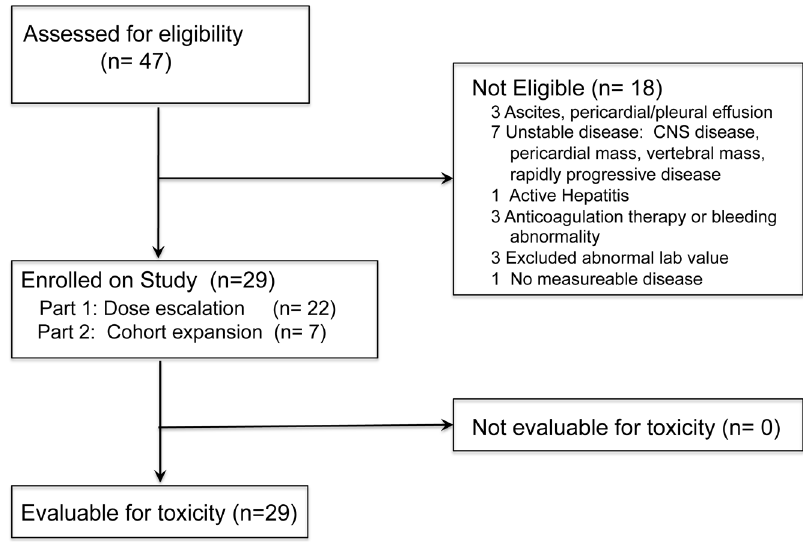
Figure 1. Patient Flow Chart.